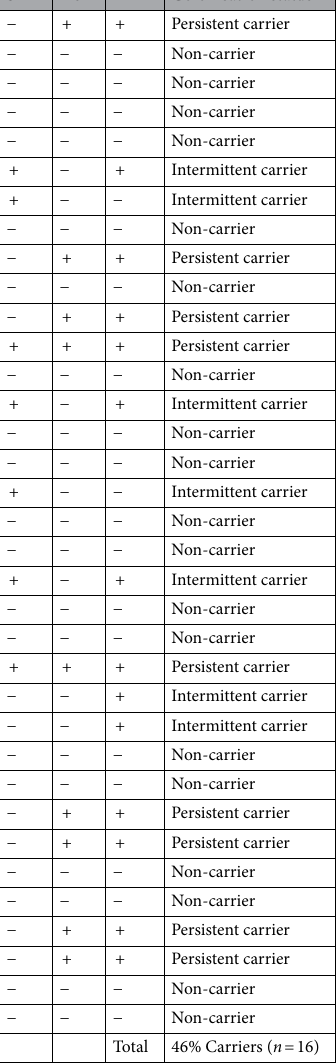
Table 2. Nasal swab results for S. aureus carriage status. The anterior nares of all volunteers ( n = 35) were sampled at baseline and days 7 and 14. Individuals were considered persistent carriers if two or more consecutive cultures were positive, intermittent carriers if one or more non-consecutive cultures were positive or non-carriers if all 3 cultures were